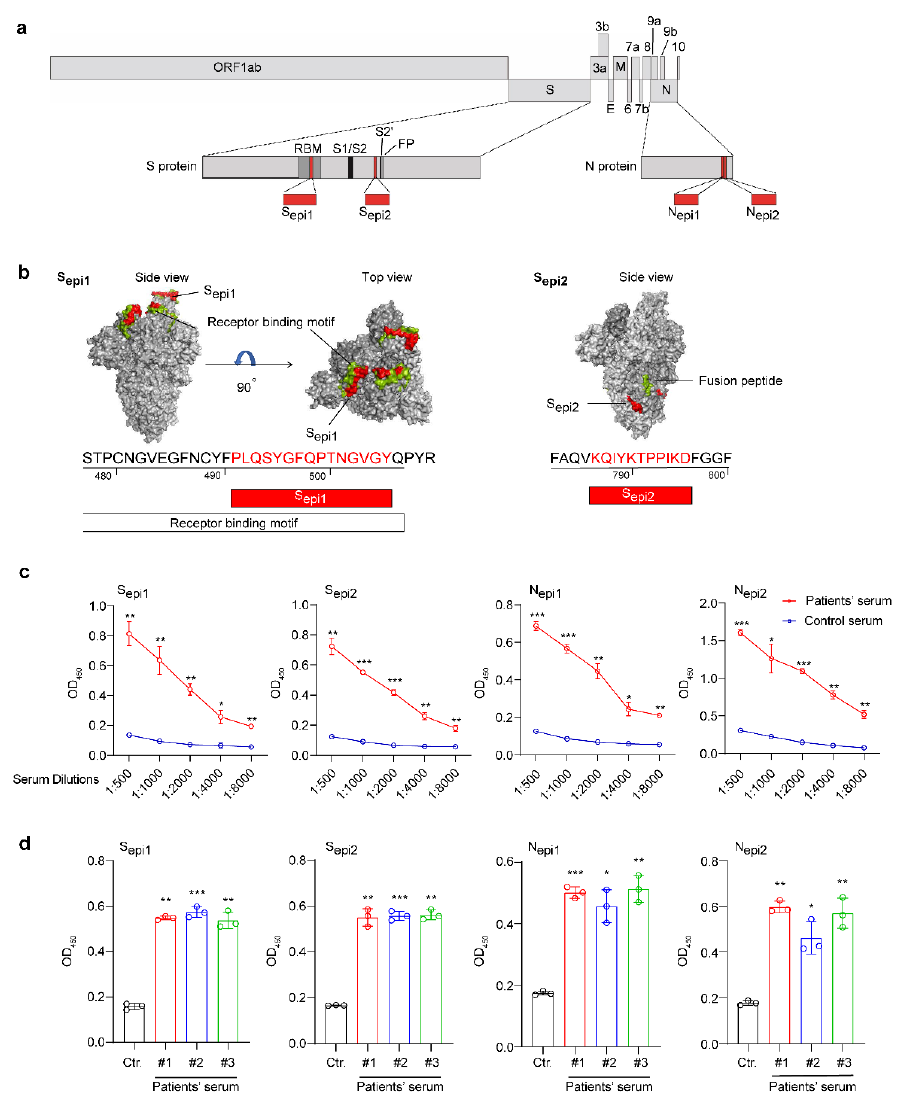
Figure 3. Identification of the antigenic epitopes of SARS-CoV-2 S and N proteins. ( a ) Schematic of the genomic structure of SARS-CoV-2. Different grey boxes represent different ORFs. The epitopes are marked in red. ( b ) Visualization of the trimeric S protein of SARS-CoV-2 based on PDB 6VYB using PyMOL. S epi1 and S epi2 are marked in red. Receptor binding motifs and fusion peptides are marked in cyan. ( c ) The reaction of a COVID-19 antibody-positive patient’s serum (red curve) and an uninfected human serum (blue curve) at different dilutions of the four peptides by ELISAs. ( d ) Reaction of 3 COVID-19 antibody-positive patients (#1, red; #2, blue; and #3 green) and uninfected human serum(black) to the four peptides by ELISA. The serum was diluted at 1:2000 (except for patient serum #1 tested with N epi2 , which was diluted at 1:4000). All data are presented as the mean ± SD from triplicate measurements. All statistical analyses were carried out with unpaired t-tests for each experiment (* p < 0.05, ** p < 0.01, *** p < 0.001).